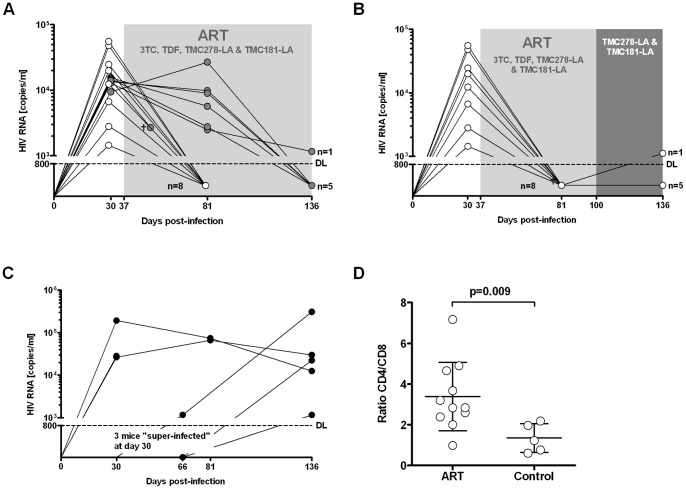
Two long-acting drugs, TMC278-LA (160 mg/kg) and TMC181-LA (400 mg/kg), are highly effective as maintenance therapy.(A) Response to a quadruple ART consisting of 3TC, TDF, TMC278-LA and TMC181-LA over a treatment period of 150 days (the black circles identifies the mice which remained over the entire time on ART (n = 7), the white circles identify the mice which were subsequently switched to a treatment with double long-acting drugs (see (B)). (B) Sustained successful suppression of HIV RNA after switching mice with suppressed HIV RNA under quadruple ART to a treatment with double long-acting drugs (n = 8). (C) Mock-treated HIV infected mice (n = 5). (D) CD4+ T-cells as determined by the CD4/CD8 cell ratio in all treated mice (ART and double long-acting drugs) and mock-treated mice at the end of the experiment.